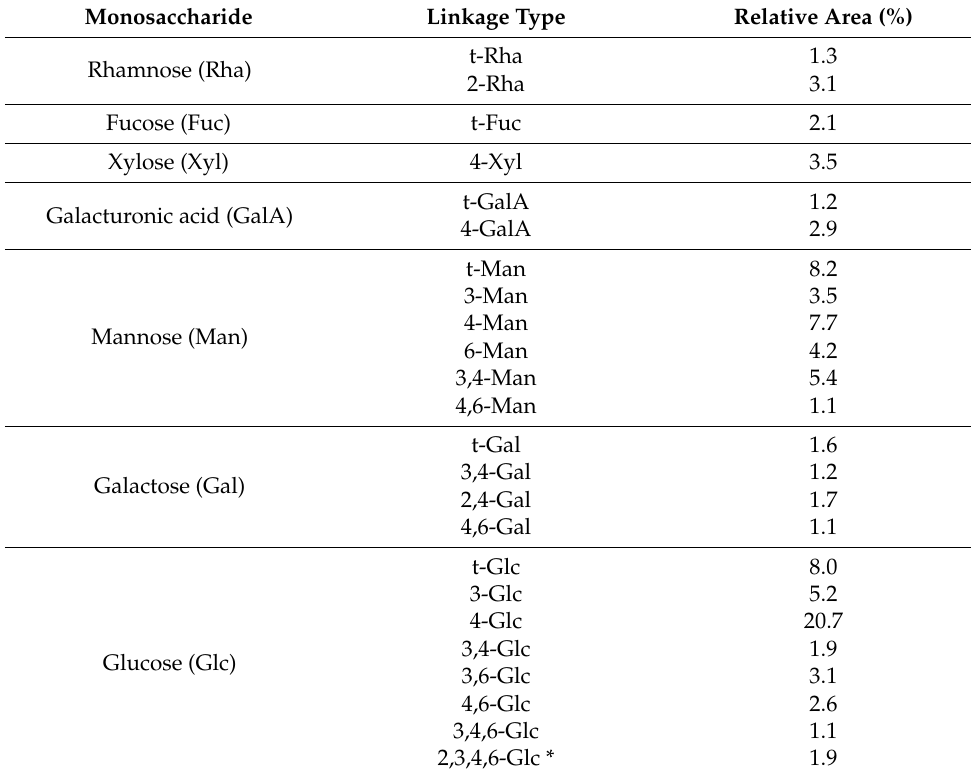
Table 2. Relative area values from glycosyl linkage by monosaccharide species in IMPP-Rb. Monosaccharide Linkage Type Relative Area (%) t-Rha 1.3 Rhamnose (Rha) 2-Rha 3.1 Fucose (Fuc) t-Fuc 2.1 Xylose (Xyl) 4-Xyl 3.5 t-GalA 1.2 Galacturonic acid (GalA) 4-GalA 2.9 t-Man 8.2 3-Man 3.5 4-Man 7.7 Mannose (Man) 6-Man 4.2 3,4-Man 5.4 4,6-Man 1.1 t-Gal 1.6 3,4-Gal 1.2 Galactose (Gal) 2,4-Gal 1.7 4,6-Gal 1.1 t-Glc 8.0 3-Glc 4-Glc 3,4-Glc Glucose (Glc)